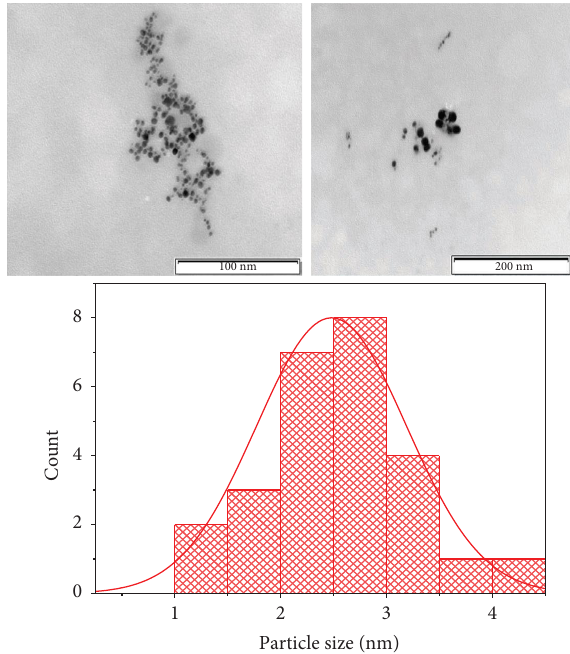
Figure 4: TEM images and particle size distribution of AgNPs synthesized by N. sativa .